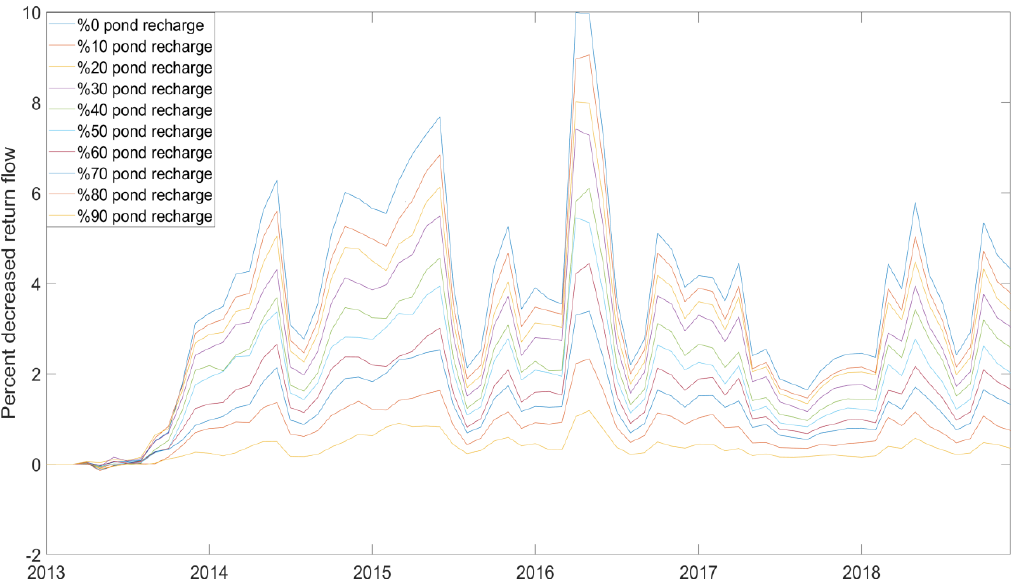
Figure 9. The interaction between the aquifer and the South Platte River corresponds to these dif- ferent scenarios. X -axis is the percent of baseline recharge pond seepage. The percent values above the bars are percent decrease in groundwater discharge from the baseline simulation. The furthest right bars are for the baseline simulation.